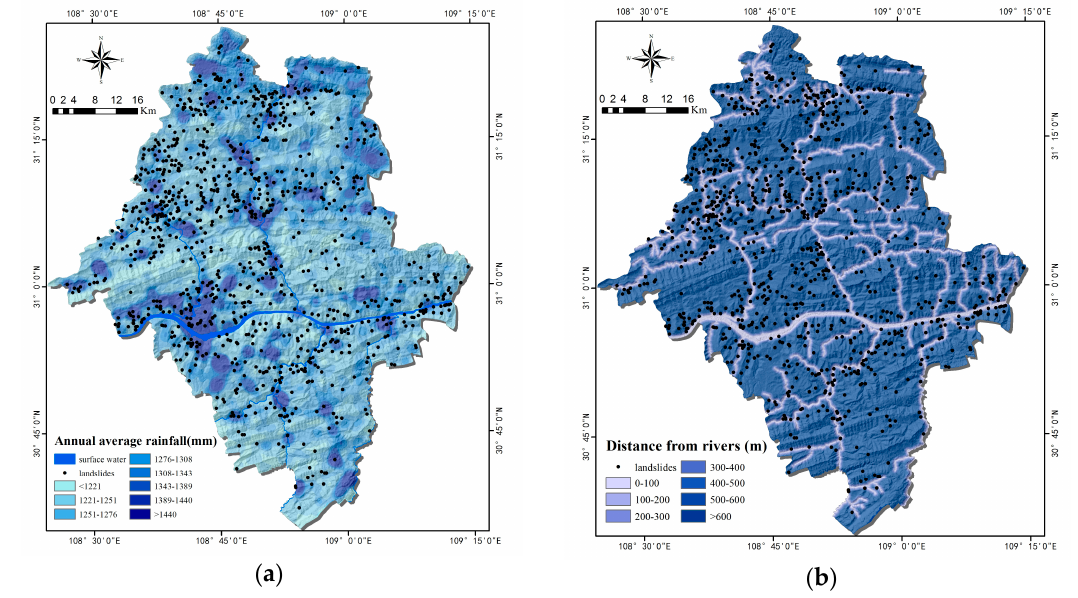
Figure 9. Thematic maps of triggering factors: ( a ) Annual average rainfall; ( b ) Distance from